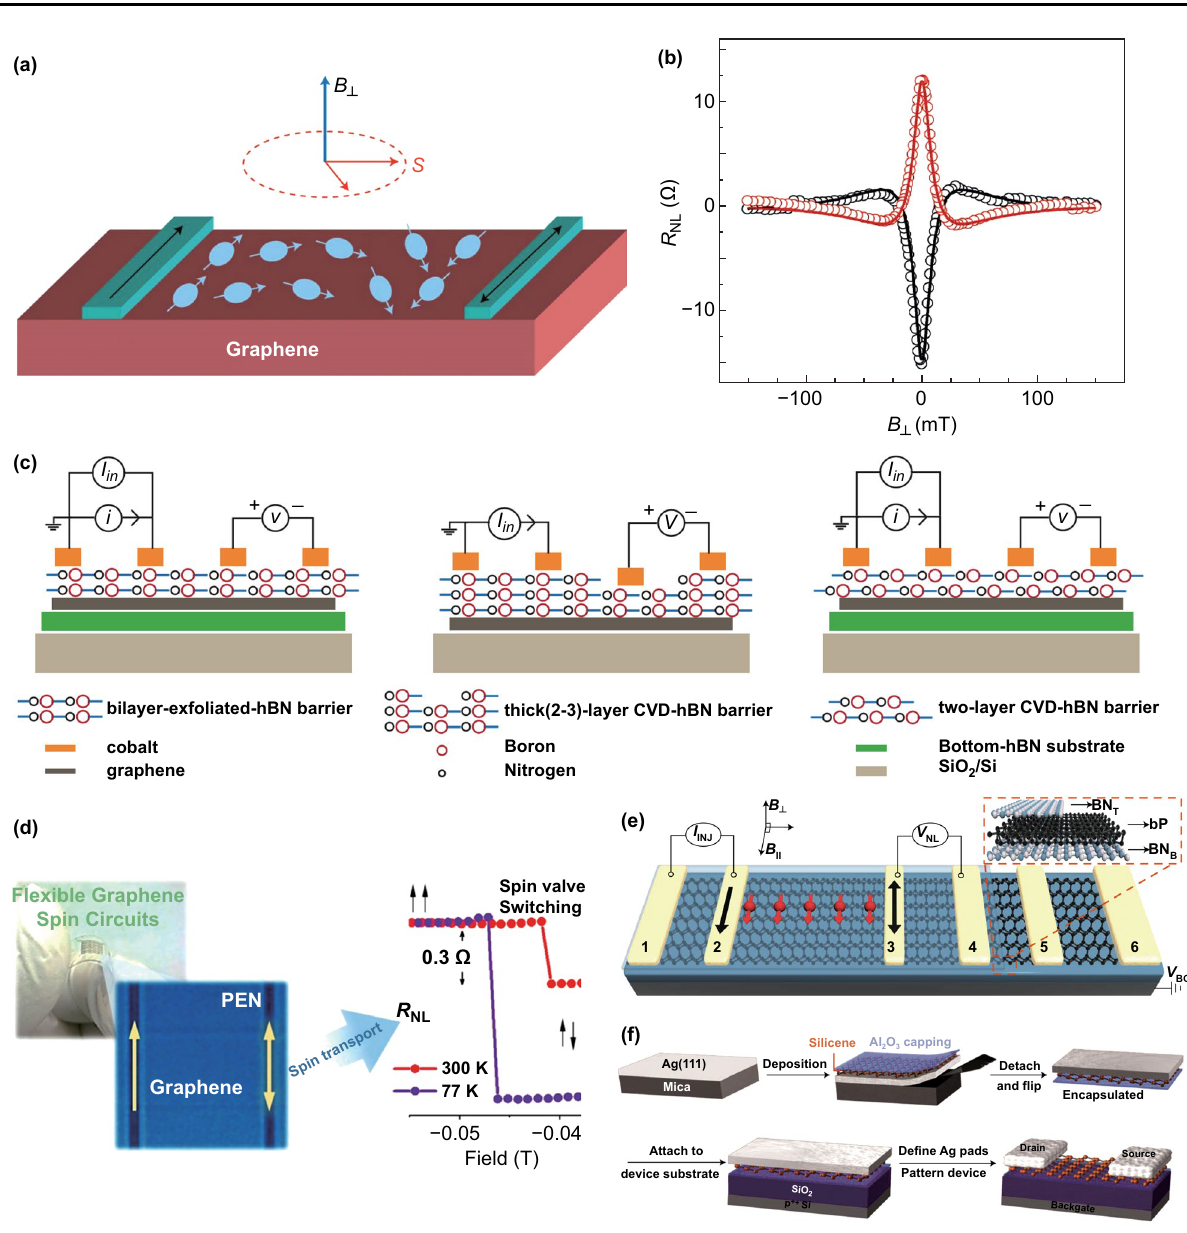
Fig. 7 a, b Schematic of Hanle measurement. Non‑local spin valve structure. Spin‑polarized electrons, generated by FM, diffuse through gra‑ phene channel and form pure spin current. When the vertical magnetic field is added, the electron’s spin will process around the field and a clas‑ sical Hanle signal can be obtained by scanning the magnetic field [15]. c Comparison diagram of the different hBN as a tunnel barrier [125]. d Schematic of flexible graphene spin circuits [142]. e Non‑local spin valves structure with BP [154]. f Schematics of silicene FET and its synthe‑ sis–transfer–fabrication process, which includes the following key steps: epitaxial growth of silicene on crystallized Ag(111) thin film, in situ